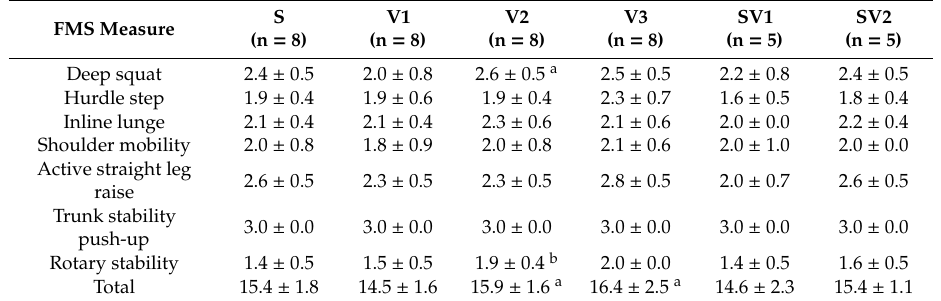
Table 1. FMS results (mean ± SD) by clothing ensembles and Functional Movement Screen (FMS) movement task and overall.